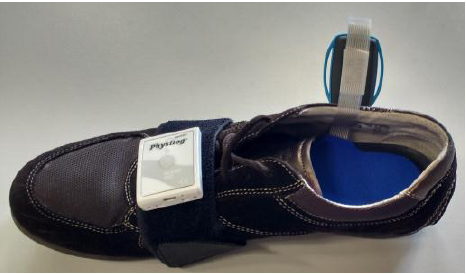
Figure 1. Instrumented shoe system (right shoe). The Physilog ® is placed on a strap looping around the shoe with Velcro ® tape. The insole (in blue) is placed inside the shoe and linked to the Physilog ® by a cable. Converting electronics are in the box with handles (lateral side of the shoe), connected to the strip stemming from the insole.